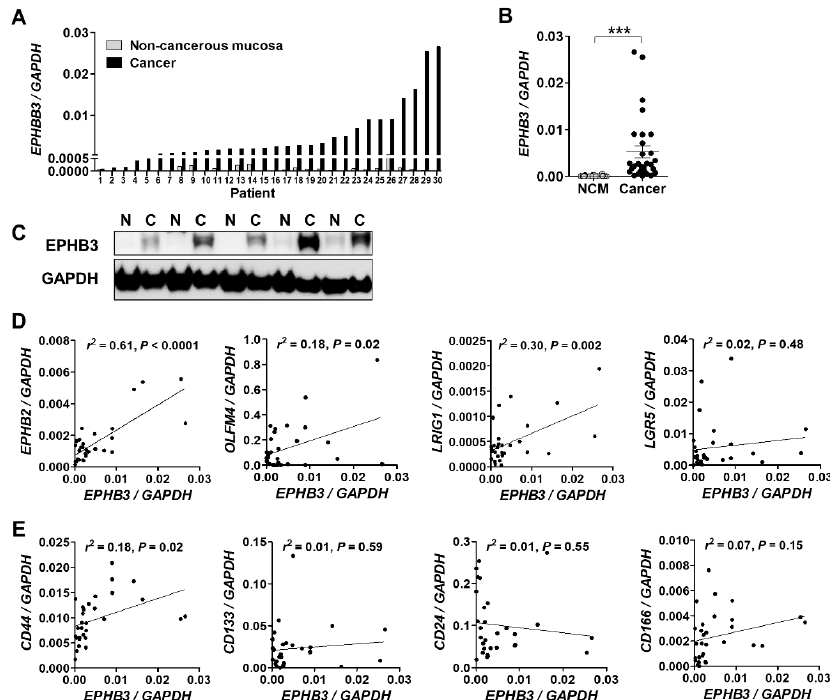
Figure 1. The expression of intestinal and cancer stem cell markers, and Ephrin type-B receptor 3 (EPHB3) in human colorectal cancer samples. Real-time PCR analysis of the expression of intestinal stem cell markers ( EPHB2, OLFM4, LRIG1, and LGR5 ) and cancer stem cell markers ( CD44, CD133, CD24, and CD166 ) from 32 pairs of fresh-frozen colorectal cancers (CRCs) samples and matched, non-cancerous mucosa (NCM). ( A , B ) EPHB3 expression level was significantly higher in cancers than in NCM. Data are presented as the mean ± SEM. SEM: standard error of the mean. ( C ) Expression of EPHB3 in normal and colon cancer tissues by immunoblotting. ( n = 6) ( D ) EPHB3 expression positively correlated with EPHB2, OLFM4, and LRIG1, but not with LGR5. ( E ) EPHB3 expression also positively correlated with CD44 expression. N, normal; C, cancer. *** p < 0.001.